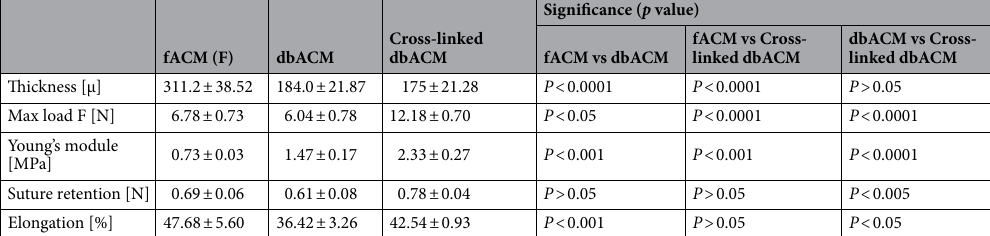
Table 1. Biomechanical properties of dbACM, cross-linked dbACM, and fACM.